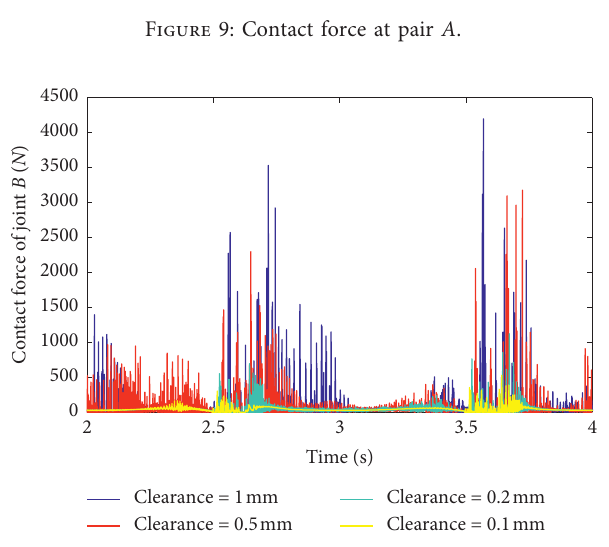
Figure 10: Contact force at pair B .